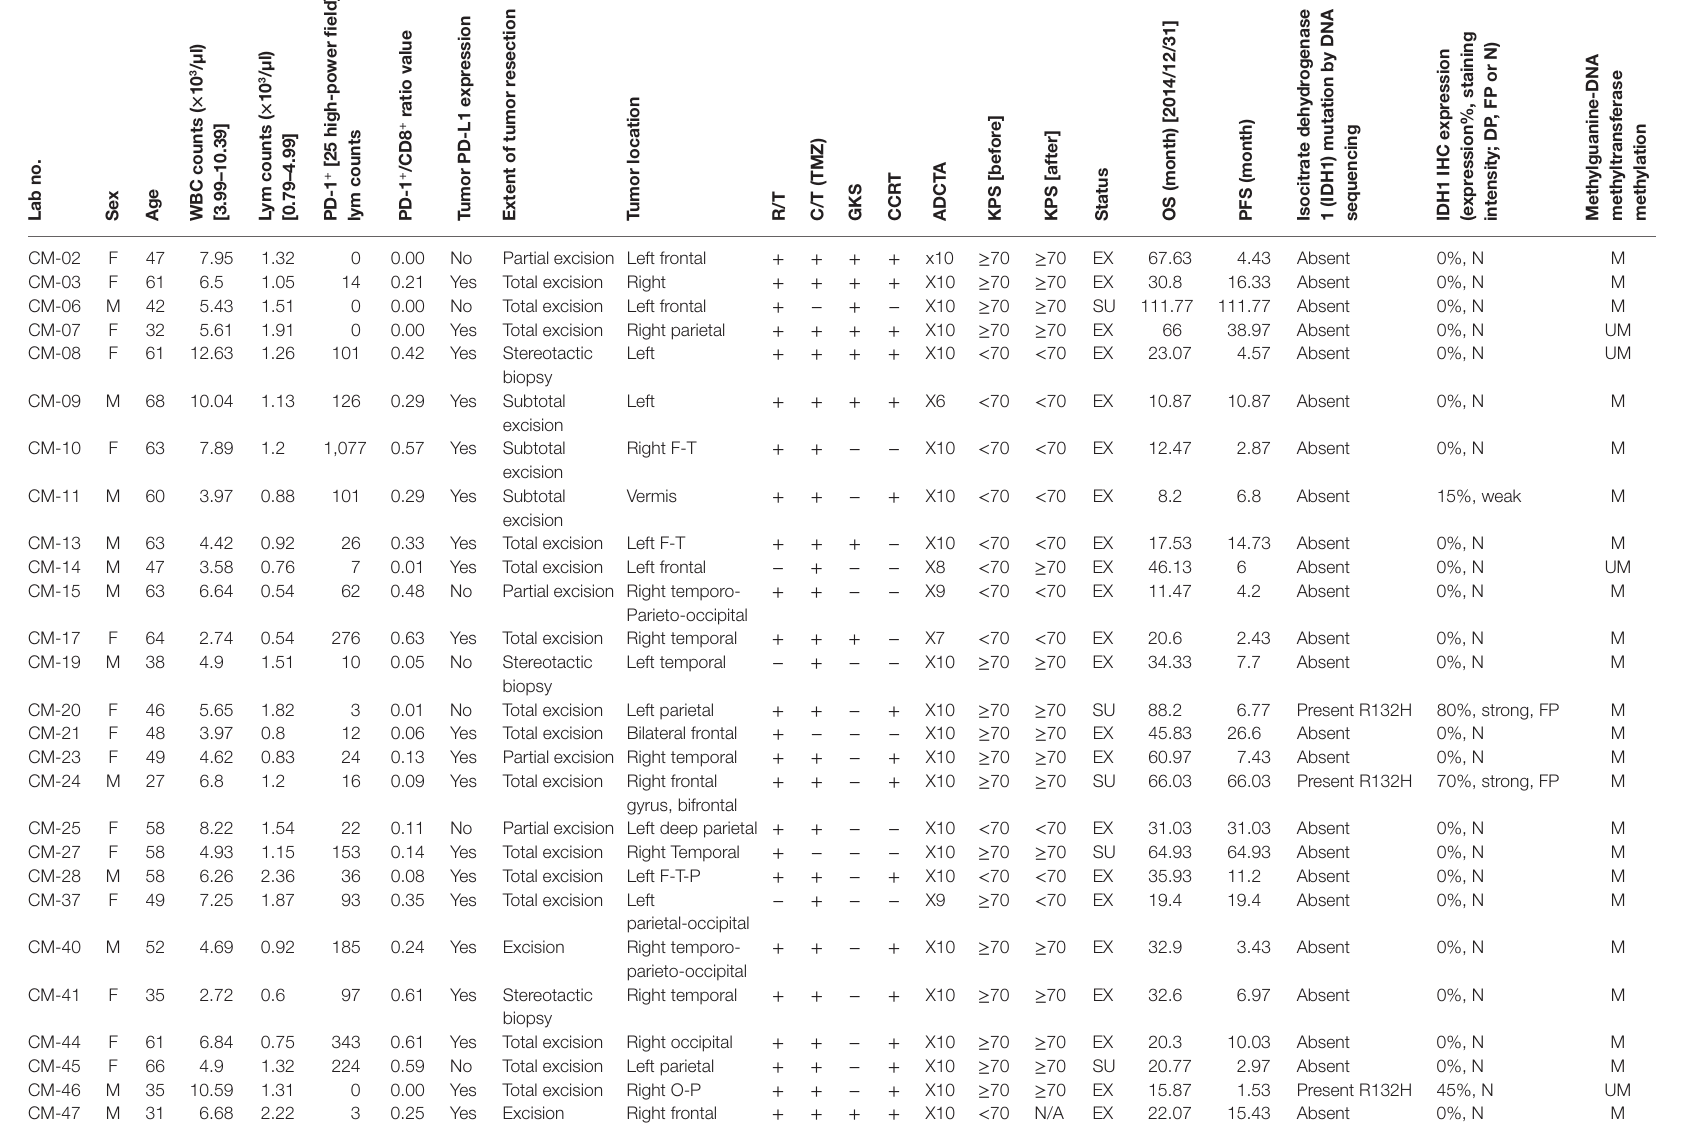
TaBle 2 | Summary of patient data in the ADCTA